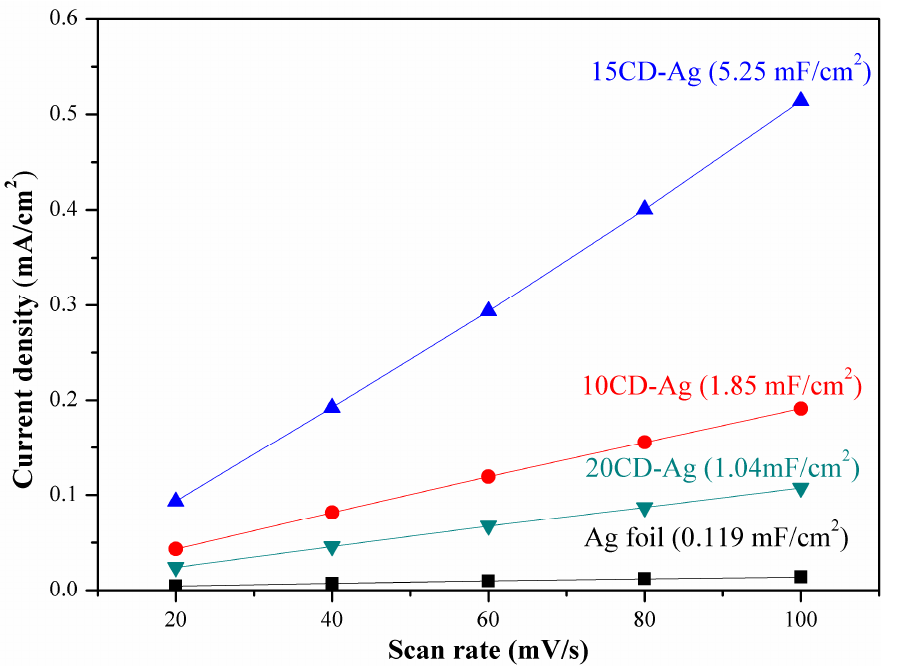
Figure 5. The linear regression of the C dl of Ag foil and three different CD-Ag electrodes and the C dl values listed in parentheses.